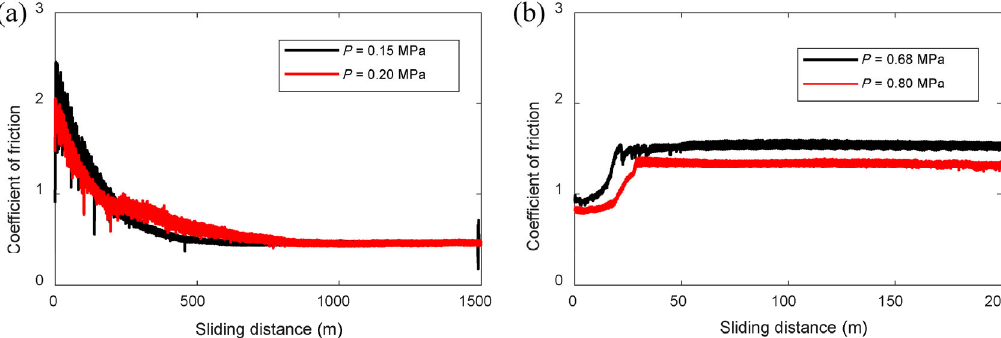
Fig. 3 Coefficients of friction as a function of sliding distance for different contact pressures: (a) composite 15 SF and (b) composite 20 SF+silica. All composites have randomly oriented fibers.